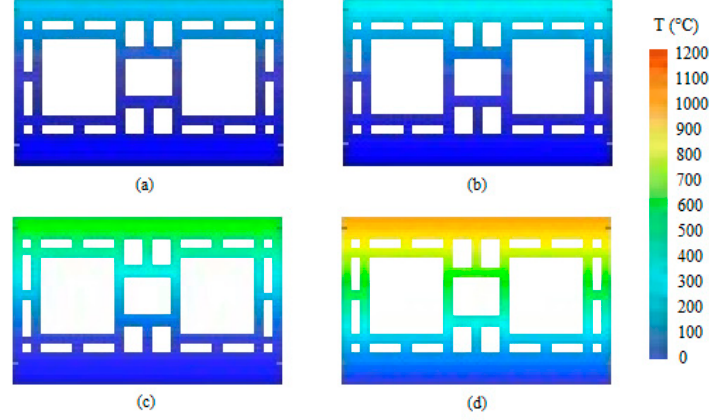
Figure 11. Temperature distribution at ( a ) 30 min, ( b ) 60 min, ( c ) 120 min, and ( d ) 240 min.